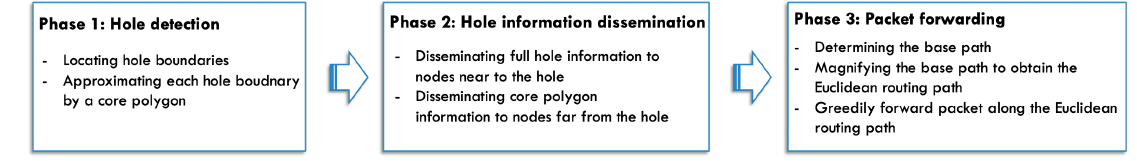
Figure 1. The overview of our